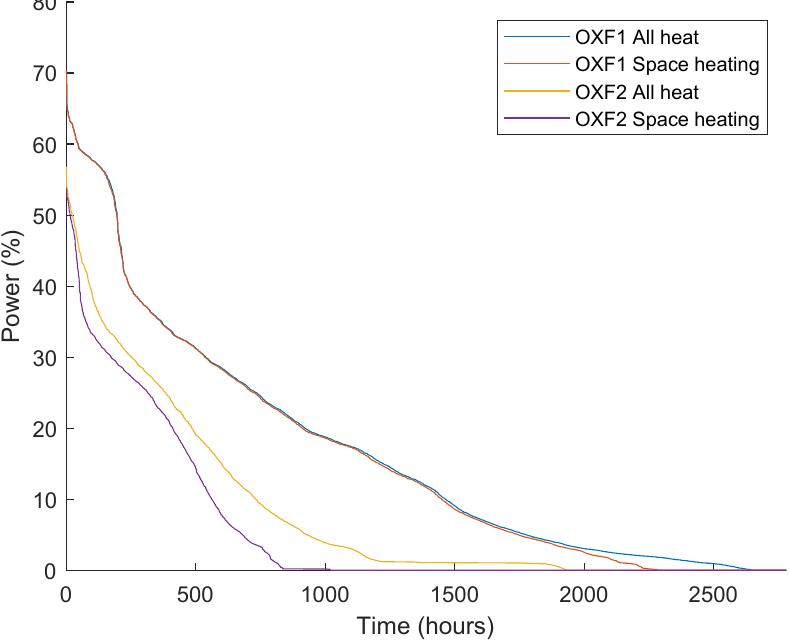
Figure 4. Load duration curves, all boiler demand and space heating only (OXF1 and OXF2).